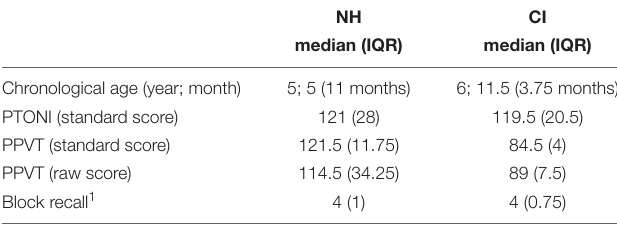
TABLE 1 | Demographic information for all participating